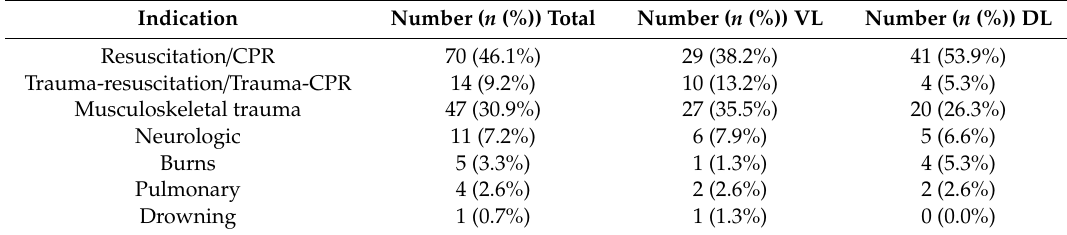
Table 1. Indication for endotracheal intubation (ETI) in the study